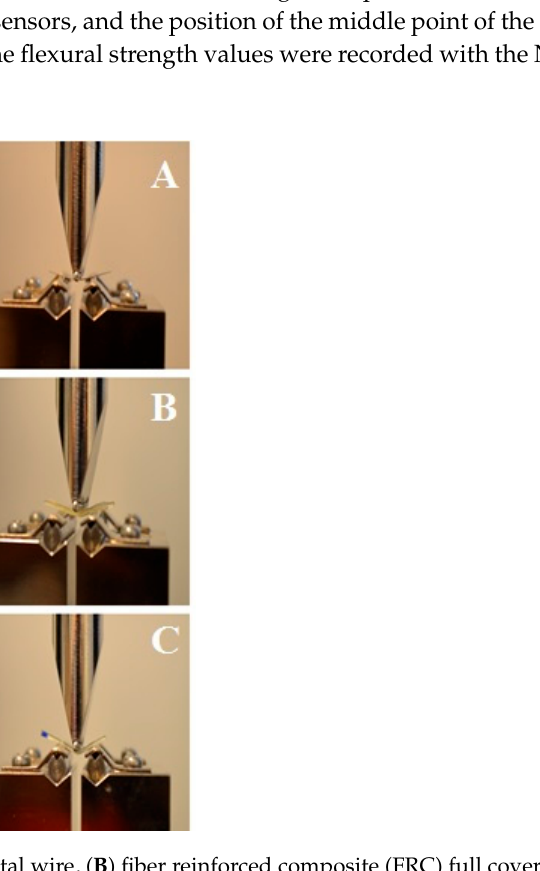
Table 1. Descriptive statistics of the different groups at maximum load (N). Group Material Coverage Brushing Mean St Dev Min Mdn Max Significance* 1